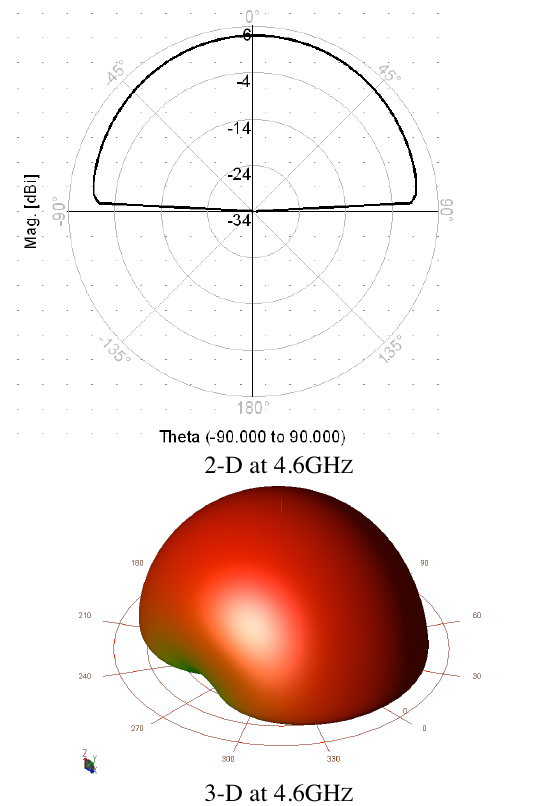
Figure.4. Antenna radiation gains patterns in elevation ( 0 Φ = degree).